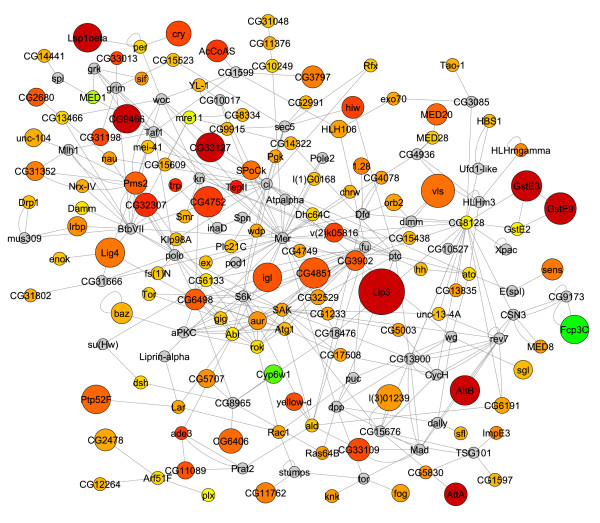
sticky mutant active sub-network. Highest scoring sub-network found by jActiveModules using sticky mutant expression data. Red indicates genes that are up-regulated in the sticky mutant compared to wild type and green indicates down-regulation. Yellow nodes represent genes with little to no change in expression and gray nodes represent genes that could not be assigned expression data. Node size indicates the significance (i.e. p-value) of the change in expression, where larger nodes are more significant and smaller nodes are less significant.